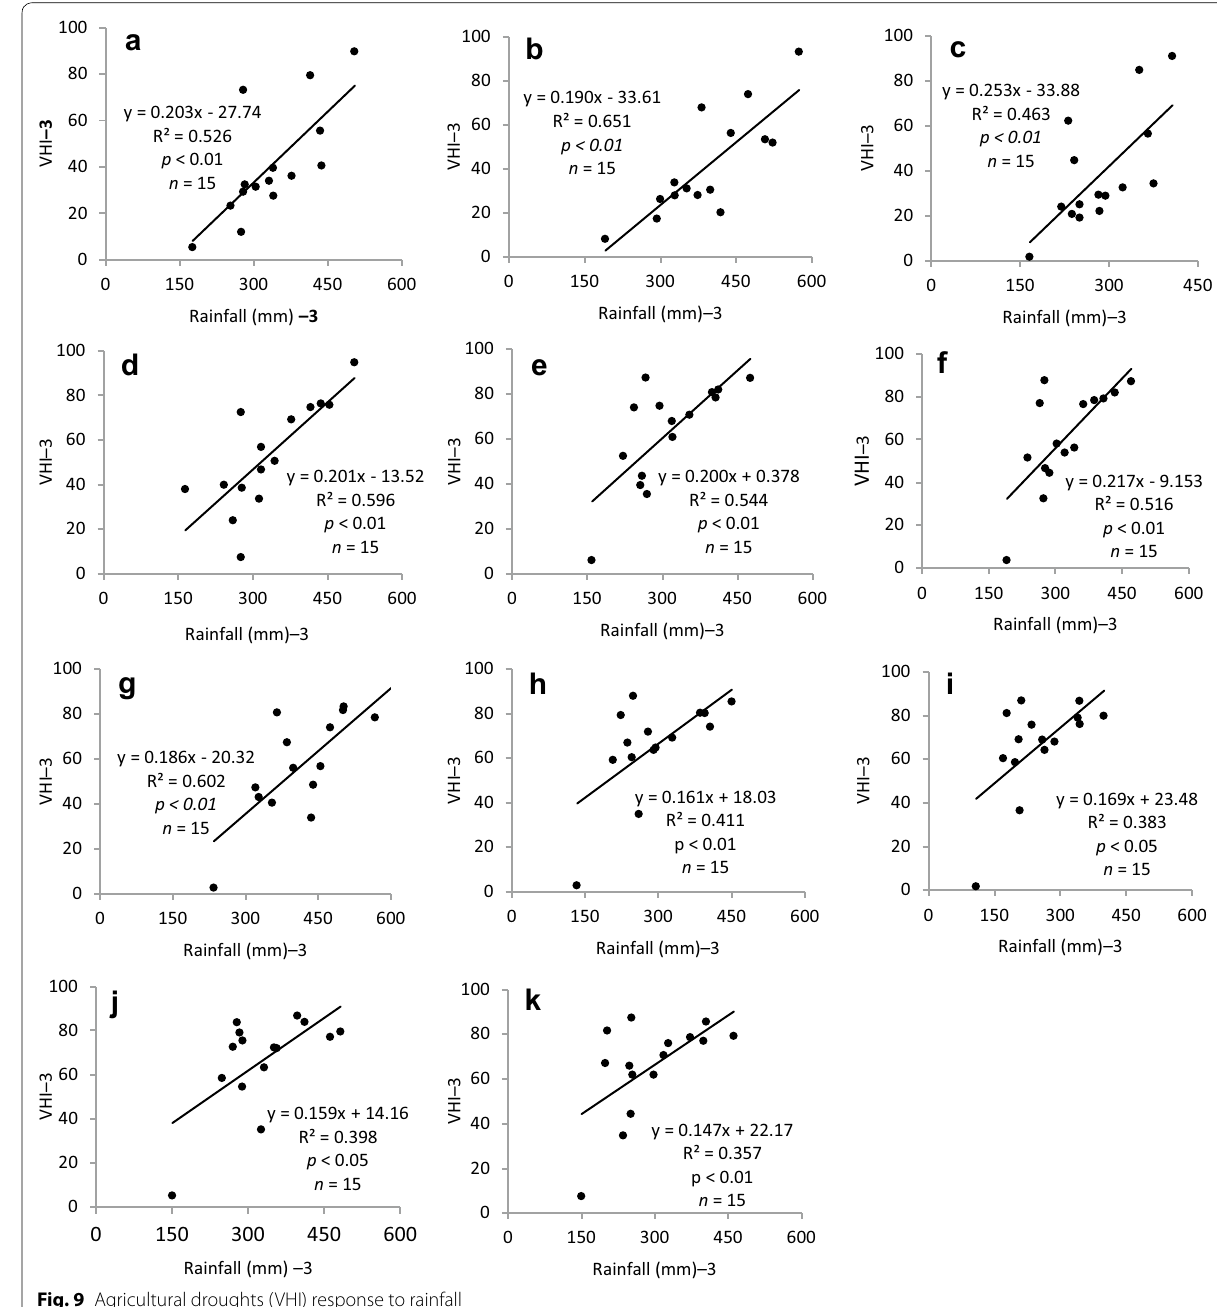
Fig. 9 Agricultural droughts (VHI) response to